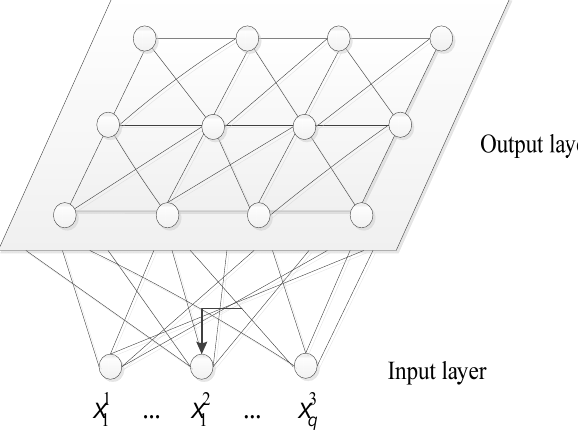
Figure 4. DSR clustering recognition based on SOM.